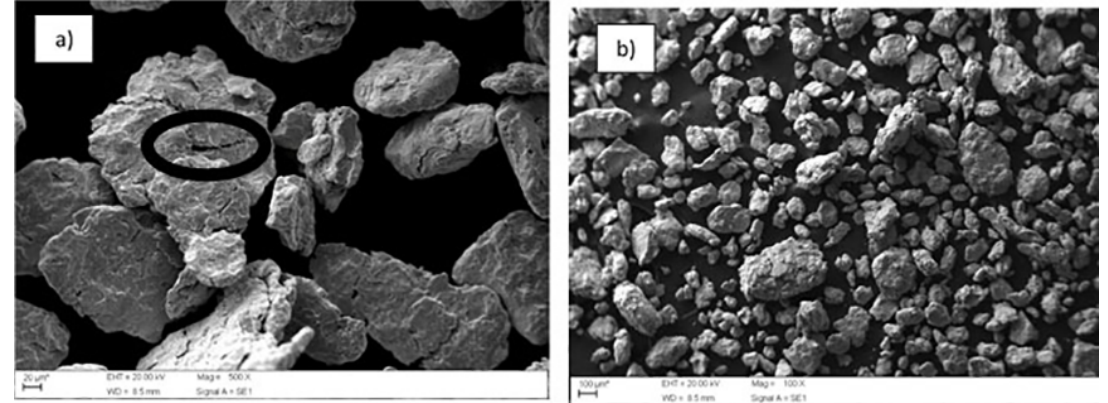
Figure 3. Particles of the duplex stainless steel after (a) 5 hours and (b) 20 hours of the milling.